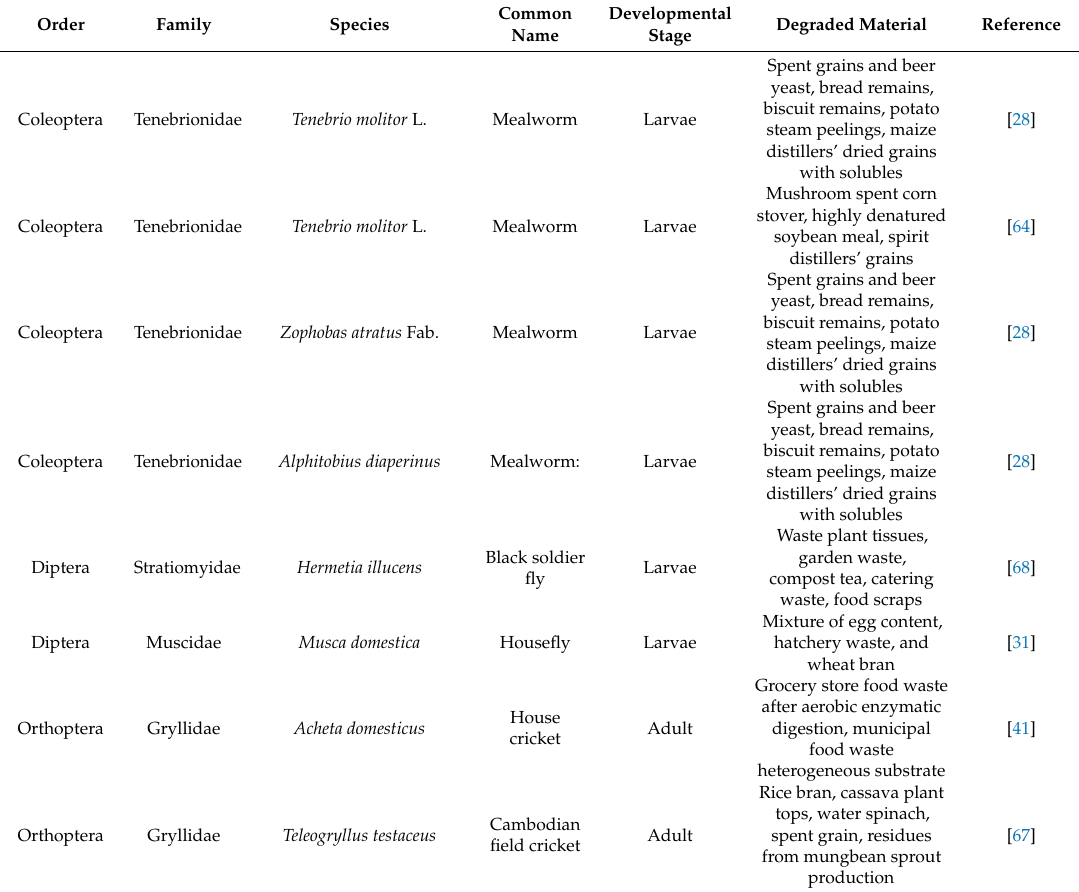
Table 2. Summary of various edible insect species reared on food wastes and their